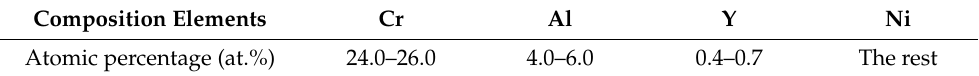
Table 1. The composition elements of the coating and corresponding atomic percentages. Composition Elements Cr Al Y Ni Atomic percentage